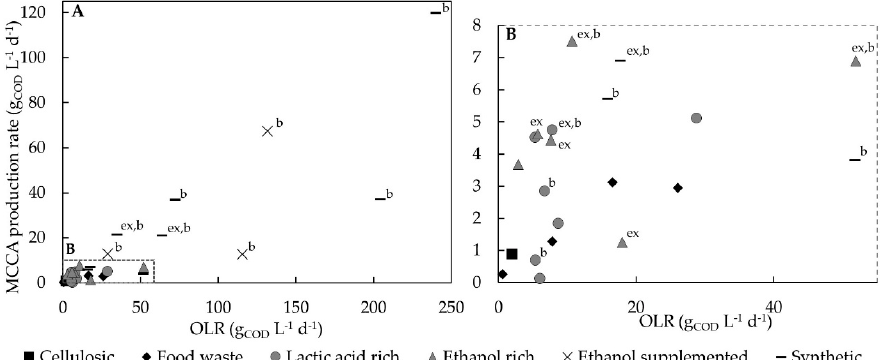
Figure 3. The highest reported MMCA (C6 to C9) production rate as a function of OLR and type